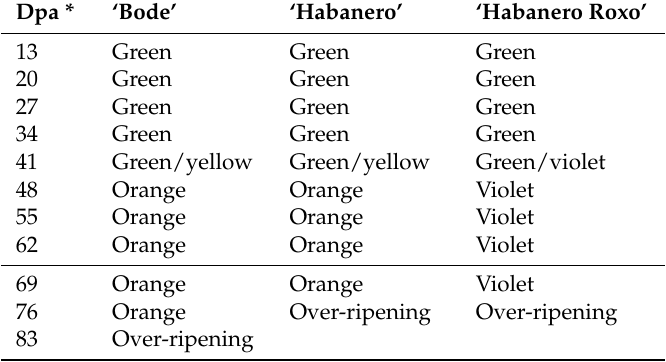
Table 1. Evolution of fruit colour in the cultivars, ‘Bode’, ‘Habanero’, and ‘Habanero Roxo’, during the pepper fruits’ development (dpa).